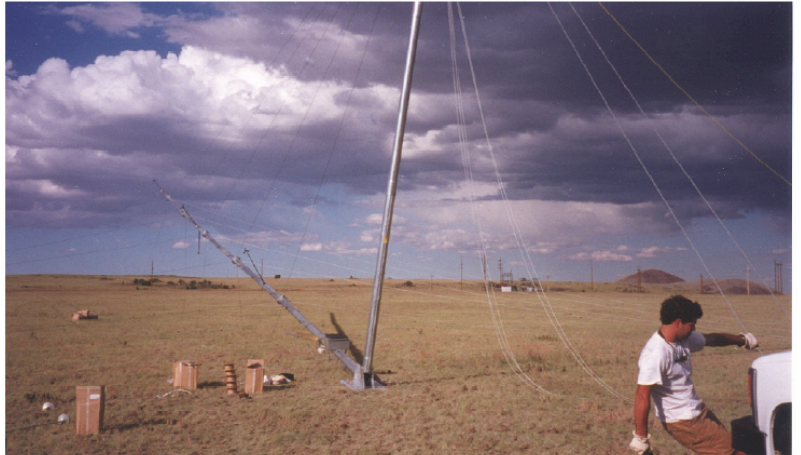
Figure 1. Meteorological mast erection using gin pole and